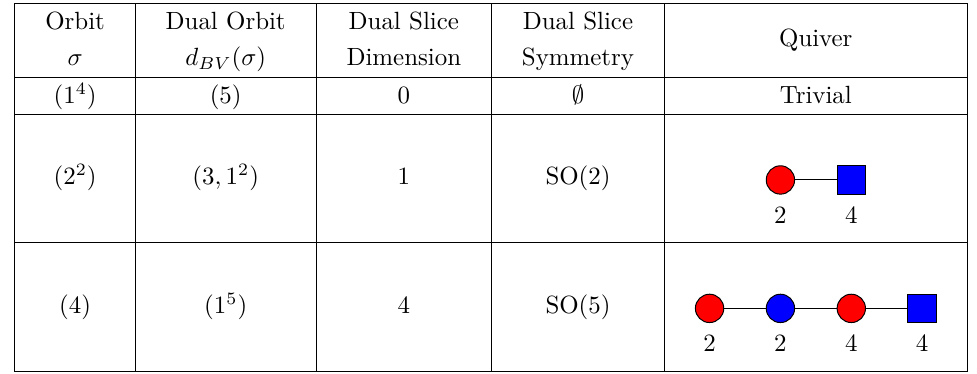
Table 20. T (USp(4)) linear quivers. These are used in twisted A 3 fixtures. The quivers